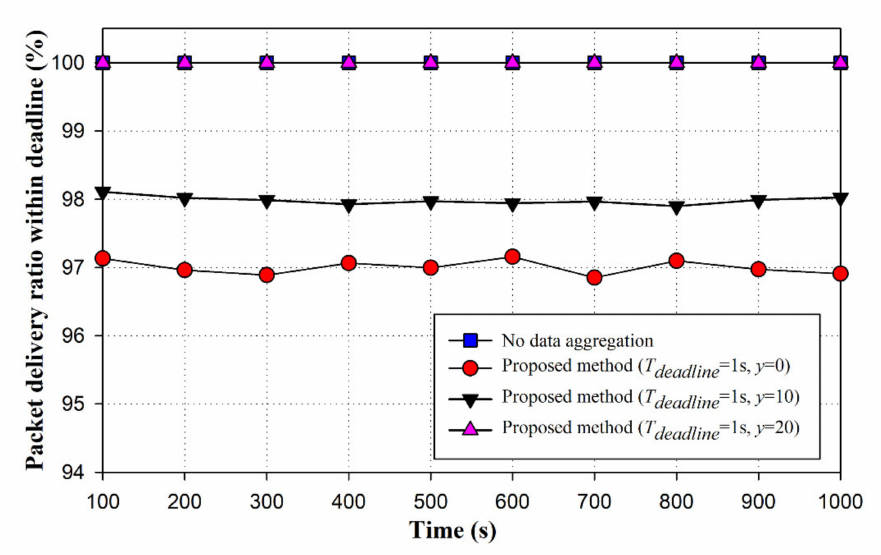
Figure 6. Packet delivery ratio with the deadline of 1 s.